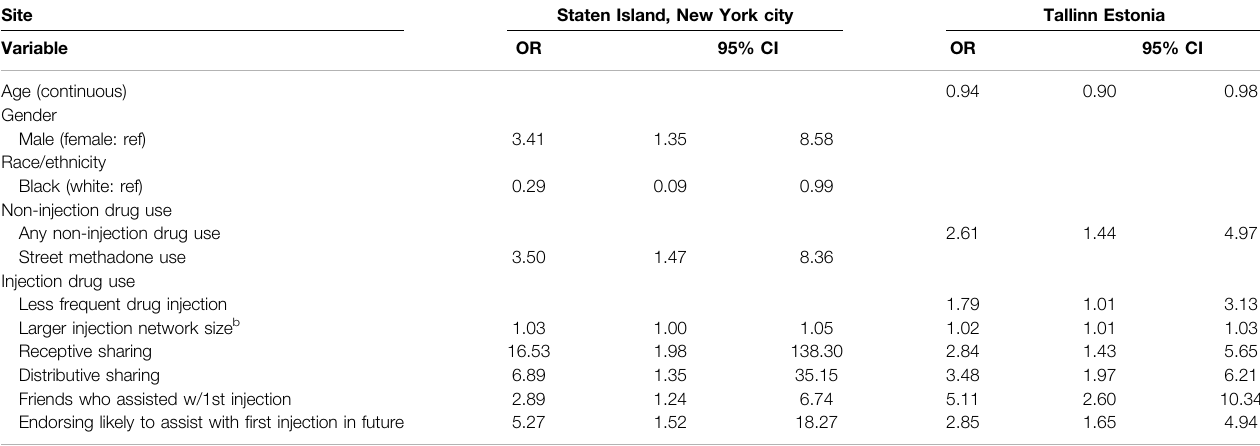
TABLE 2 | Factors signi fi cantly associated with injection promoting behavior a among PWID in Tallinn and Staten Island, New York City.